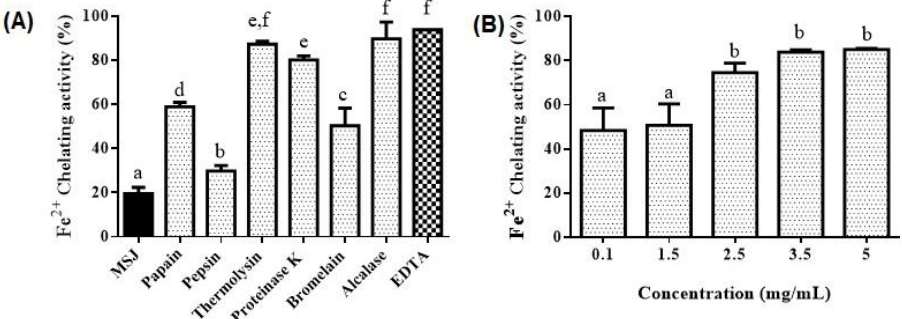
Figure 9. ( A ) Fe 2+ chelating activity of MSJ, MSJ hydrolysates and EDTA. ( B ) Fe 2+ chelating activity of alcalase hydrolysates with different concentration. Different alphabets on the bar show significant difference at p < 0.05.